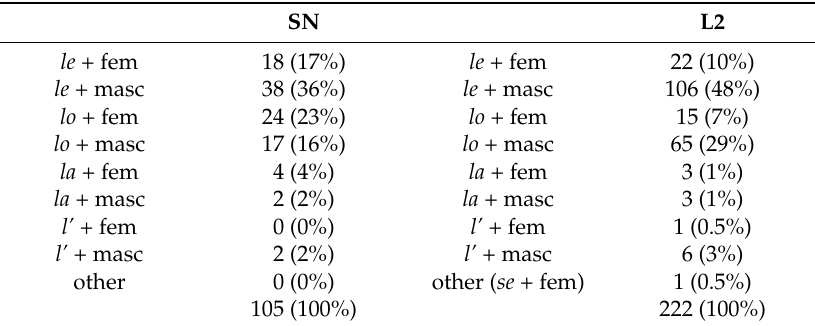
Table 7. Clitics according to the gender of the antecedent or the doubled